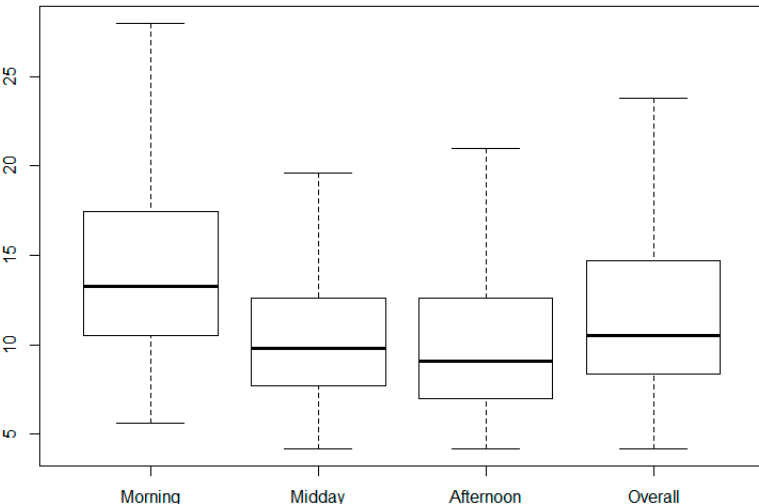
Figure 6. Boxplot of PM 2.5 concentration along Anzac Parade in the morning (07:00–09:30), midday (09:30–16:00), and afternoon (16:00–19:00). The black lines are the median values, and the box includes the upper and lower quartiles (inter-quartile range). The whiskers extend to 1.5 × the inter-quartile range. For clarity, outliers were removed from the figure if they exceeded beyond the edge of the whiskers. Only sections along Anzac Parade were included, to ensure that any measurements taken at a distance from the main road would not influence apparent temporal variations.